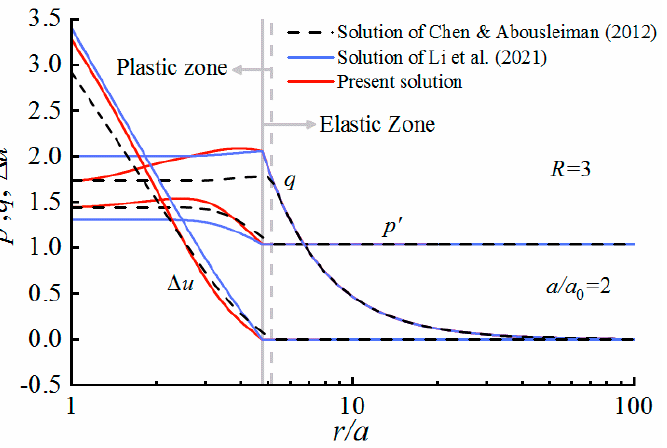
Figure 7. Comparison between the present solution and the previous solutions: distributions of p ′ , q , and Δ u along r / a .